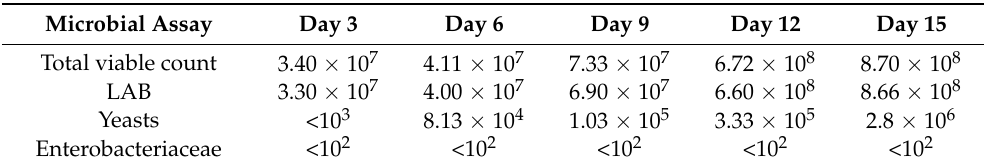
Table 6. Changes in microbial community during chili fermentation (CFU/g) conducted on C. annuum cv. Cayenne type chilies at different times. Microbial